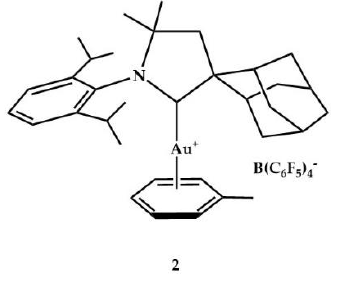
Figure 2. Cationic gold(I) complex 2 .